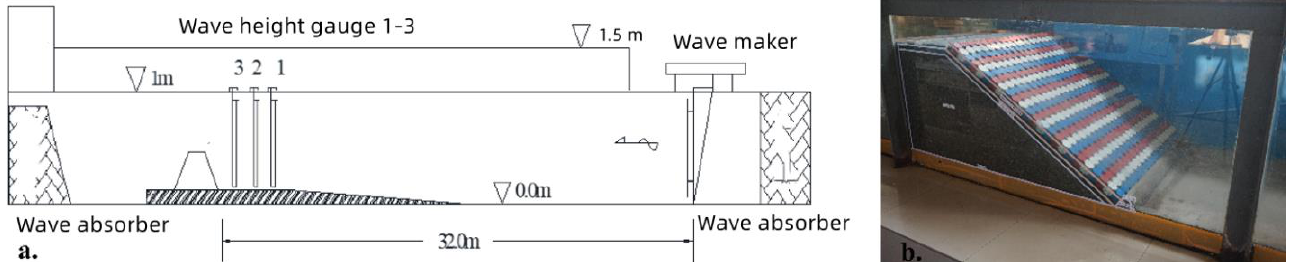
Figure 2. ( a ) Sketch of model layout; ( b ) Model photo with breakwater slope, m = 2.